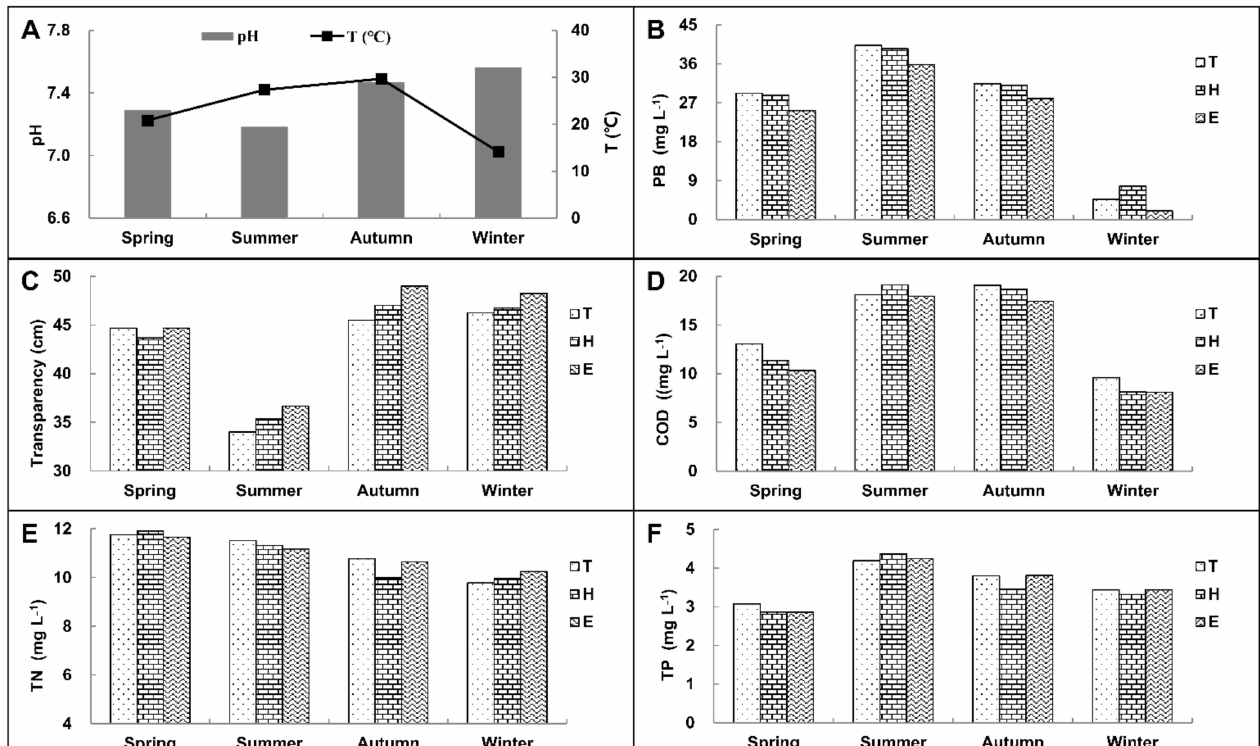
Figure 5. Mean seasonal variations in typical properties of temperature and pH ( A ), purifying effects of H. cumingii on PB ( B ), transparency ( C ), COD ( D ), TN ( E ), and TP ( F ) in the recirculating aquaculture pond. Where the letter “T” represents the tailwater discharge area, “H” represents the H. cumingii purification area and “E” represents the ecological purification